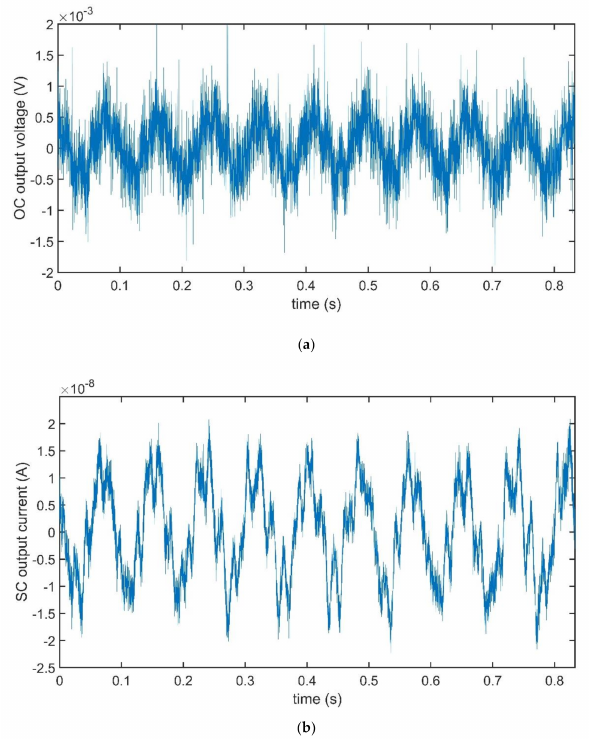
Figure 10. Time plots of OC voltage ( a ) and SC current ( b ) for the BC-CP composite. Both records were obtained by imposing a sinusoidal vibrating at the composite anchored end. The frequency of the input was fixed at 12